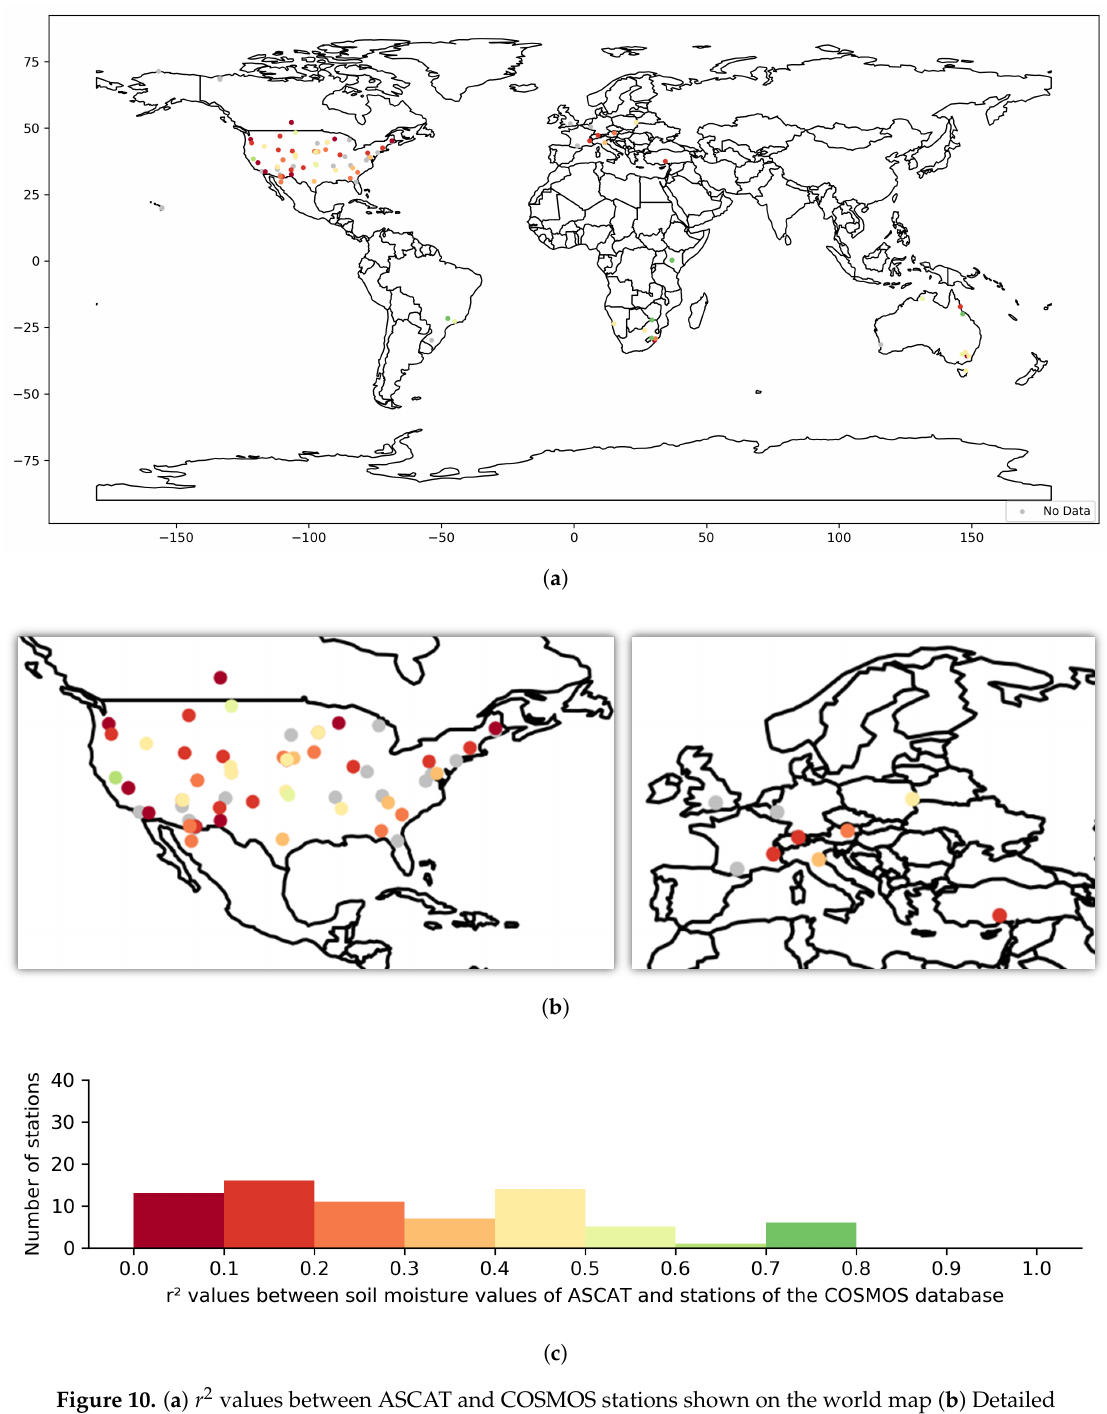
Figure 10. ( a ) r 2 values between ASCAT and COSMOS stations shown on the world map ( b ) Detailed maps of r 2 values for the North America and Europe ( c ) Histogram of r 2 values between ASCAT and COSMOS